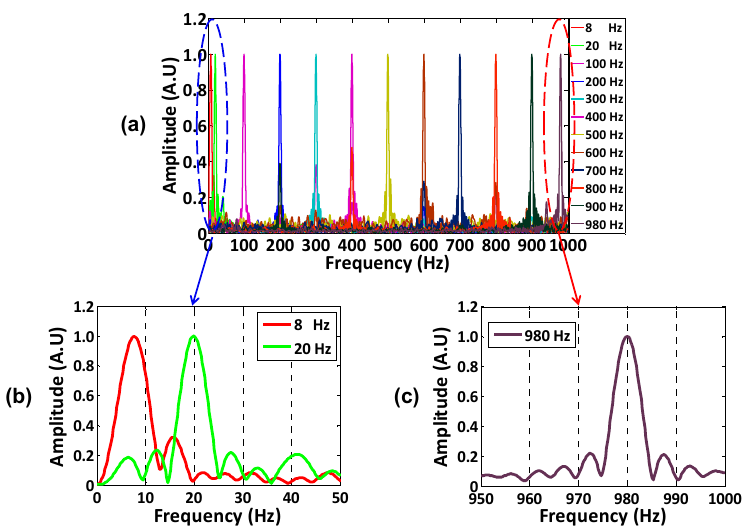
Figure 6. The frequency spectrum measured by different vibration signals. ( a ) The frequency spectrums tested in experiment; ( b ) the applied minimum frequency and ( c ) the applied maximum frequency.